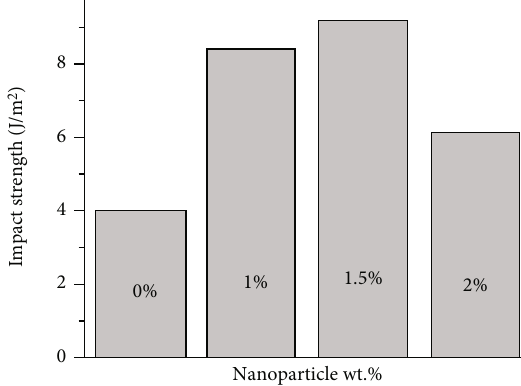
Figure 7: Impact strength of the epoxy nanocomposites.